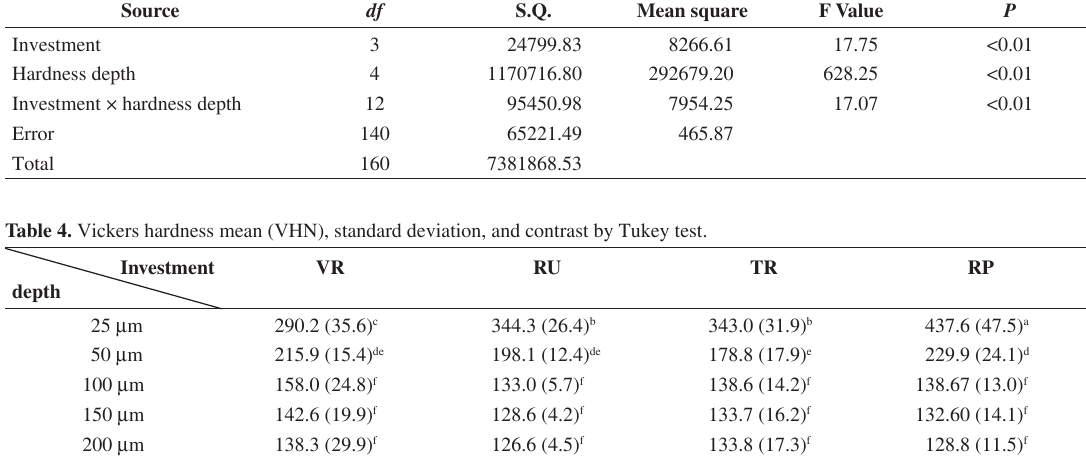
Table 3. Two-way ANOVA for surface hardness. Source